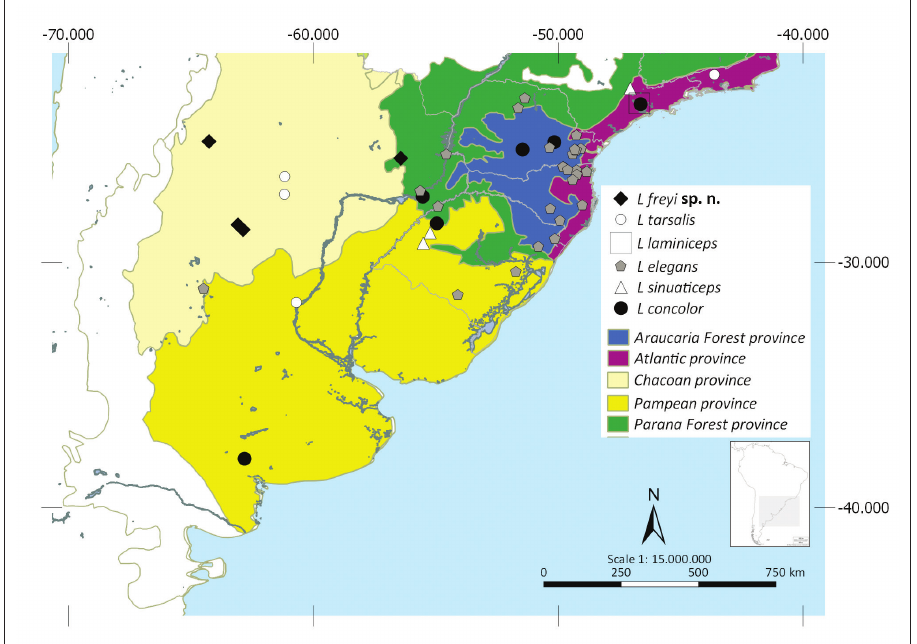
Figure 91. Distribution records of six species of Liogenys . Biomes based on Morrone